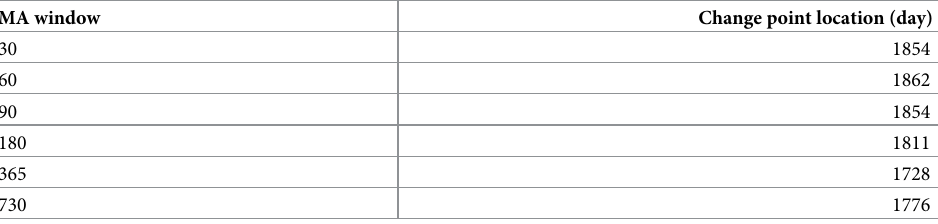
Table 2. Change points by moving average order